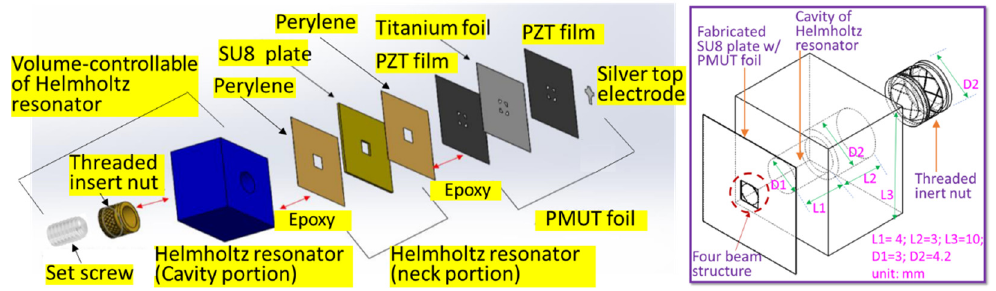
Figure 1. The configuration of the developed PMUT with a volume-controllable Helmholtz resona- tor.